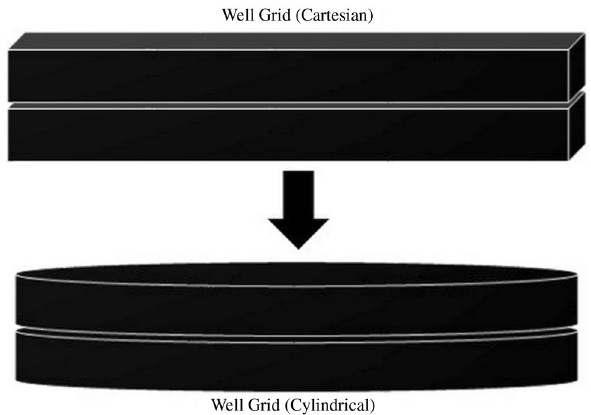
Fig. 2 Cylindrical gridding around the